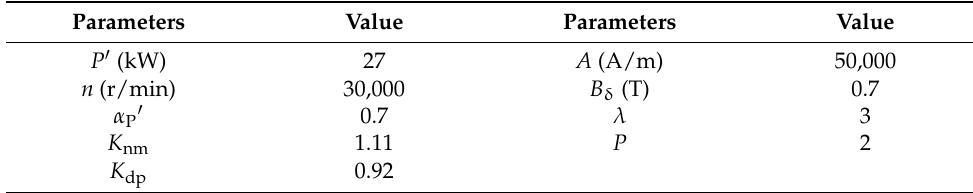
Table 1. Calculation parameters of main dimensions of